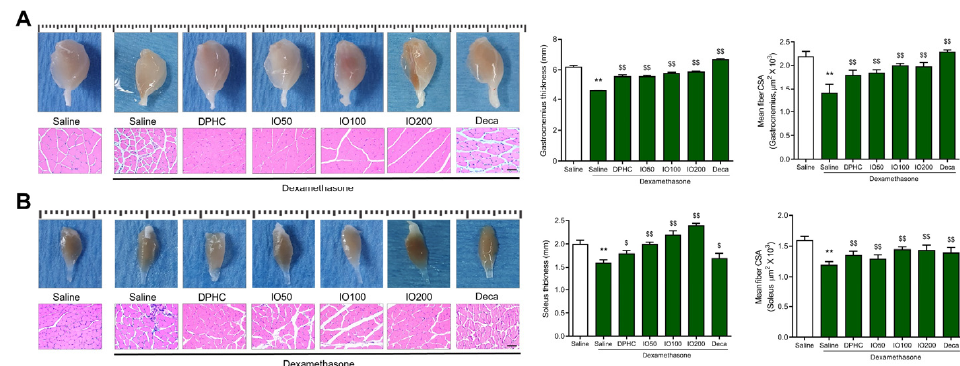
Figure 3. Representative gastrocnemius in calf muscle and its thickness were assessed in DEX-treated mice displaying muscle atrophy ( A ). H&E-stained section and cross-sectional area of gastrocnemius muscle fibers Representative soleus in calf muscle and its thickness were assessed ( B ). H&E-stained section and cross-sectional area of soleus muscle fibers. All of the lines designating dimensions in ruler above each muscle indicate length in millimeters. The thickness was measured using a ruler and is expressed in millimeters. Scale bars denote 100 µ m. Each group was examined in n = 3 mice. All values are expressed as the mean ± standard error. Significant differences are indicated as ** p < 0.01 compared with control or $ p < 0.05, $$ p < 0.01 compared with DEX-saline (Mann–Whitney U test).